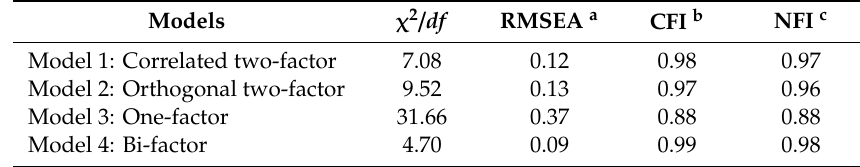
Figure 1. ( a ) Model 1: Correlated two-factor; ( b ) Model 2: Orthogonal two-factor; ( c ) Model 3: One-factor; ( d ) Model 4: Bifactor. Table 3. Fit Indices for Confirmatory Factor Analysis Models.